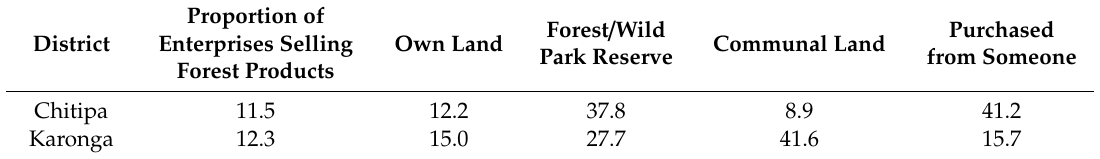
Table 1. Proportion and source of forest resources in study area districts. Proportion District